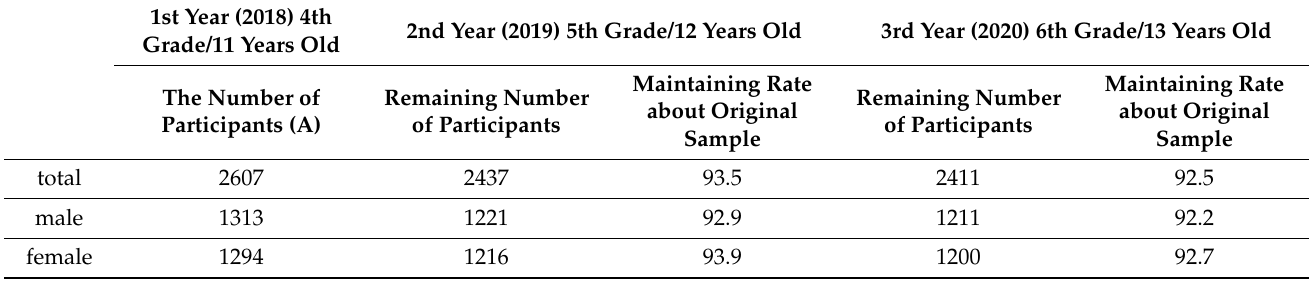
Table 1. General characteristics of